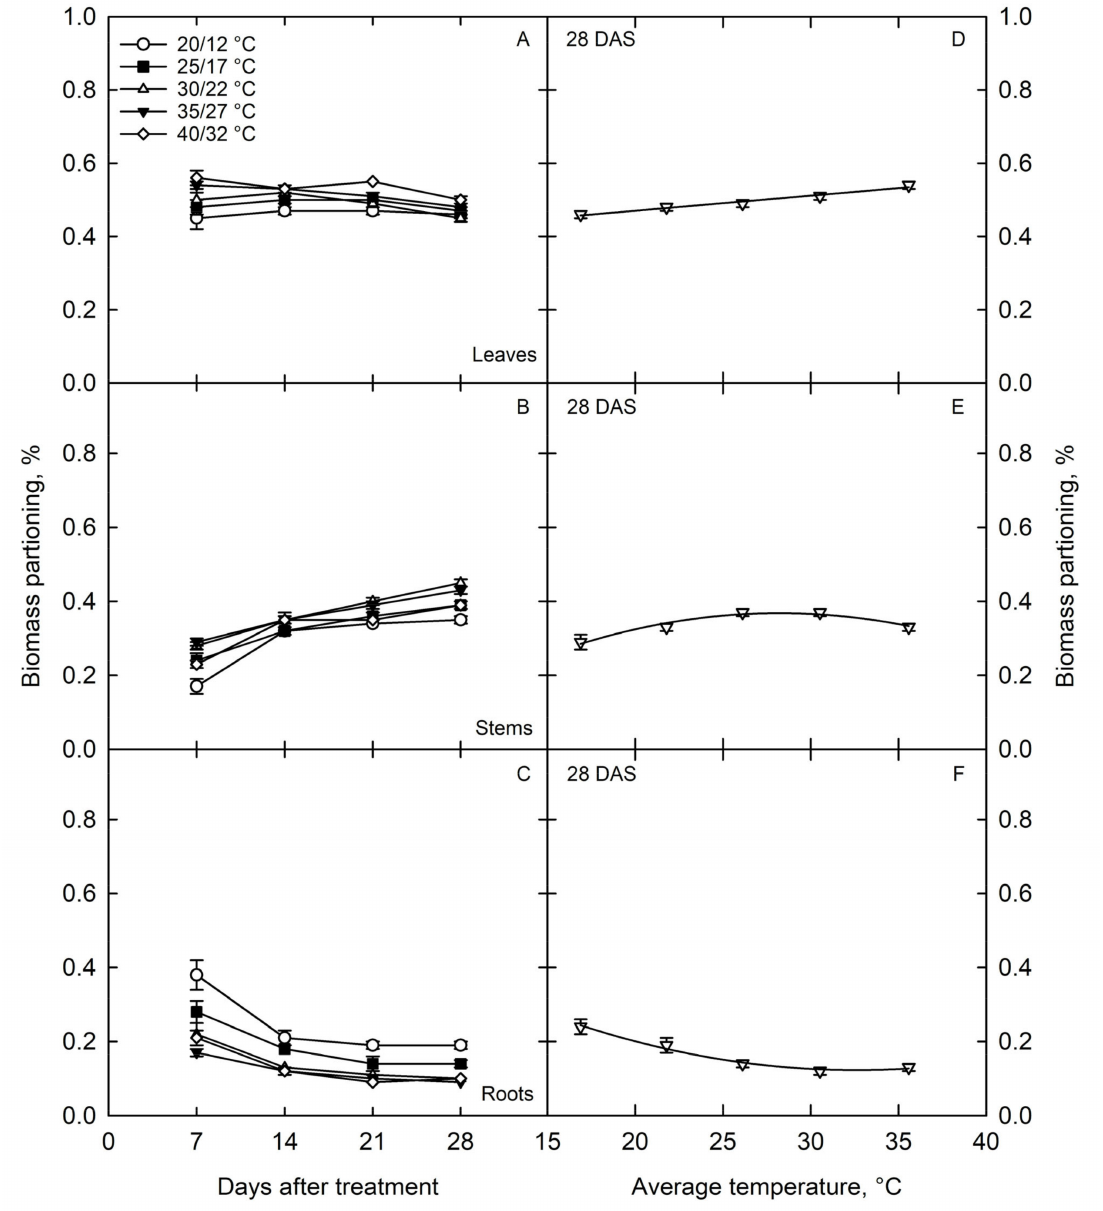
Figure 7. Temporal trends of corn biomass allocation to various plant components; ( A ) leaves, ( B ) stems, and ( C ) roots and average biomass partitioning as a function of temperature for ( D ) leaves, ( E ) stems), and ( F ) roots at various time periods as a function of